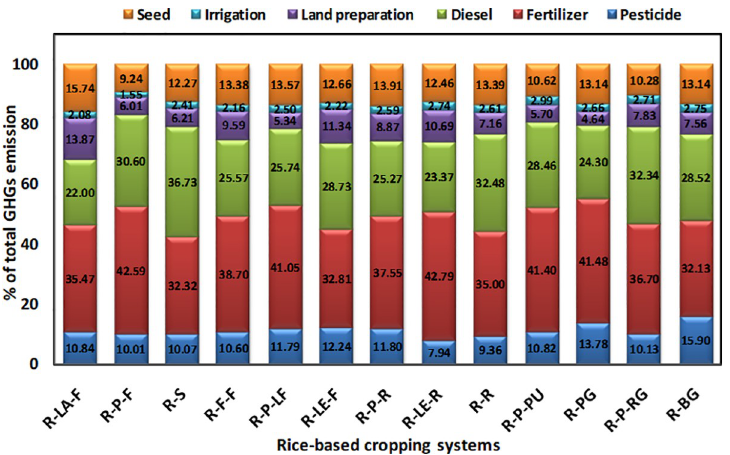
Fig 9. Percent emission of GHGs from different farm inputs for different rice-based cropping systems. [here, R-LA-F: rice-lathyrus- fallow, R-P-F: rice-potato-fallow, R-S: rice-sunflower, R-F-F: rice-fallow-fallow, R-P-LF: rice- potato-ladies finger, R-LE-F: rice-lentil-fallow, R-P-R: rice-potato-rice, R-LE-R: rice-lentil-rice, R-R: rice-rice, R-P-PU: rice-potato-pumpkin, R-PG: rice-pointed gourd, R-P-RG: rice-potato-ridge gourd, R-BG: rice-bitter gourd].